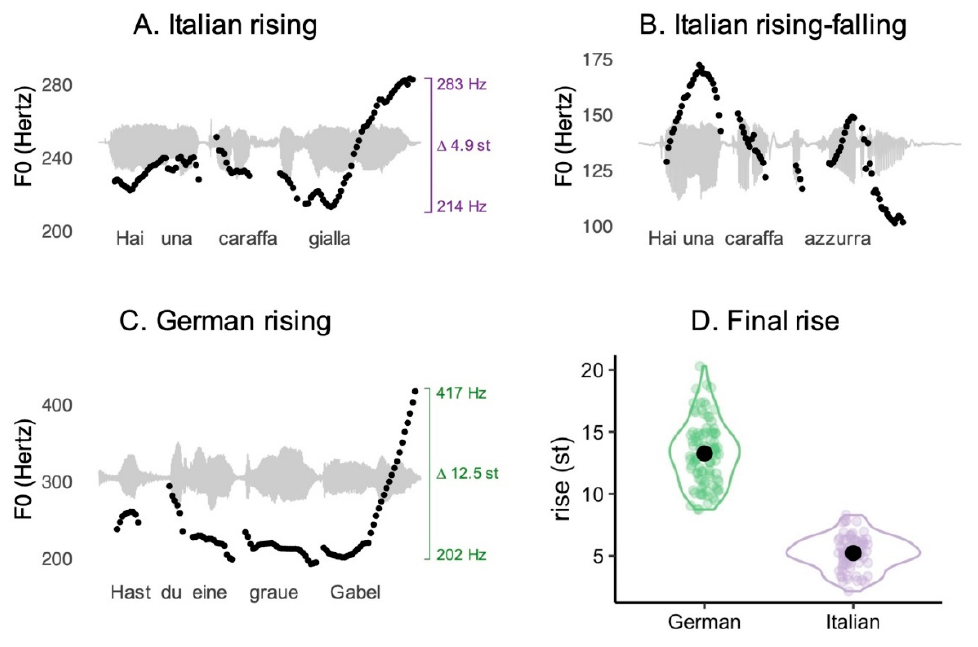
Figure A1. Example contours ( A – C ) and final rise magnitudes of German L1 and Italian L1 ( D ).